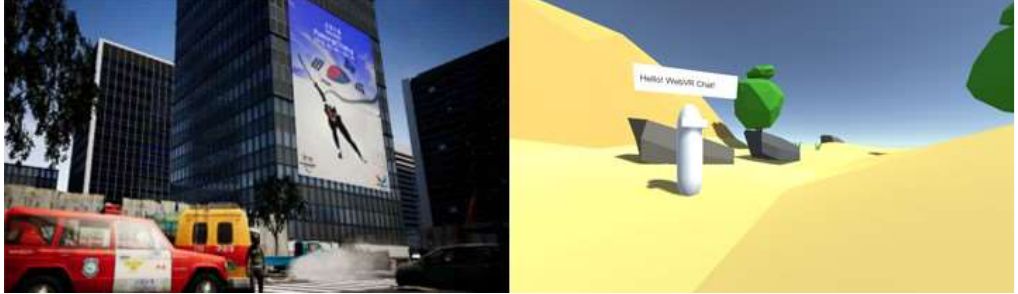
Figure 7. Industrial project fulfilment step—Beta Project.